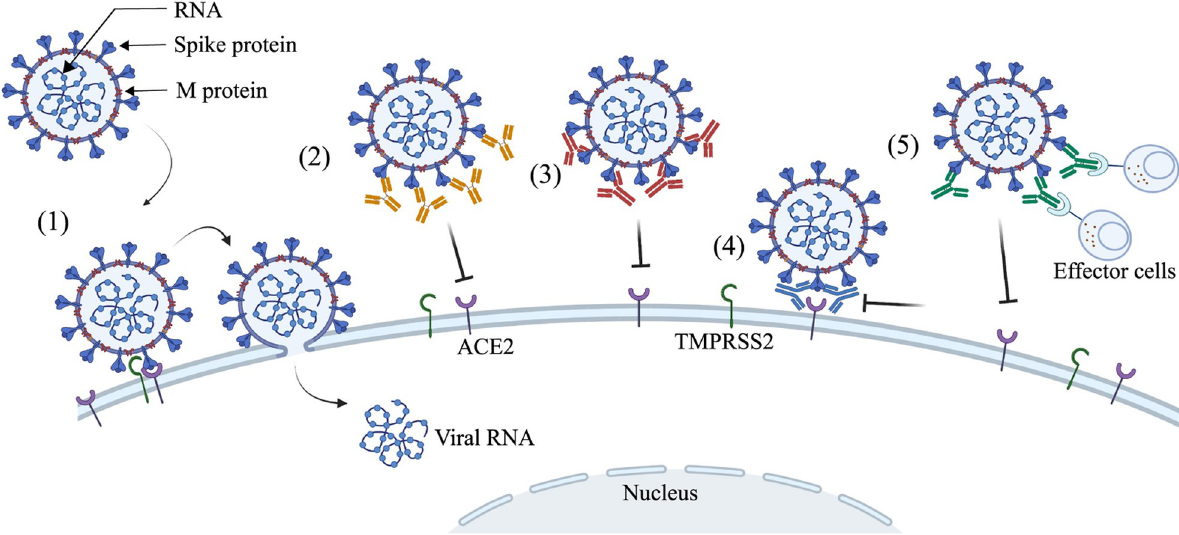
Fig 3. Antibody-mediated neutralization of envelope virus. SARS-CoV-2 virus entry into human cells is initiated by virus binding to the ACE2-cell surface receptors (point 1). The virus neutralization largely depends on the epitope targeted by antibodies. Some of the antibodies target the RBM (point 2) or NTD (point 3) or other regions of the spike protein, which can inhibit the virus spike protein and host ACE2–receptor interactions, and they are considered among the most potent nAbs. A few rare antibodies can inactive the fusion machinery by activating the premature fusion pathway, thus inhibiting the virus entry into the host cell (point 4). Some of the non-nAbs bind to the viral antigens and activate the Fc-mediated antibody effector functions for their killing or phagocytosis (point 5). The figure was prepared using BioRender. ACE2, angiotensin-converting enzyme 2; Fc, fragment crystallizable; nAb, neutralizing antibody; NTD, N-terminal domain; RBM, receptor-binding motif; SARS-CoV-2, Severe Acute Respiratory Syndrome Coronavirus 2.